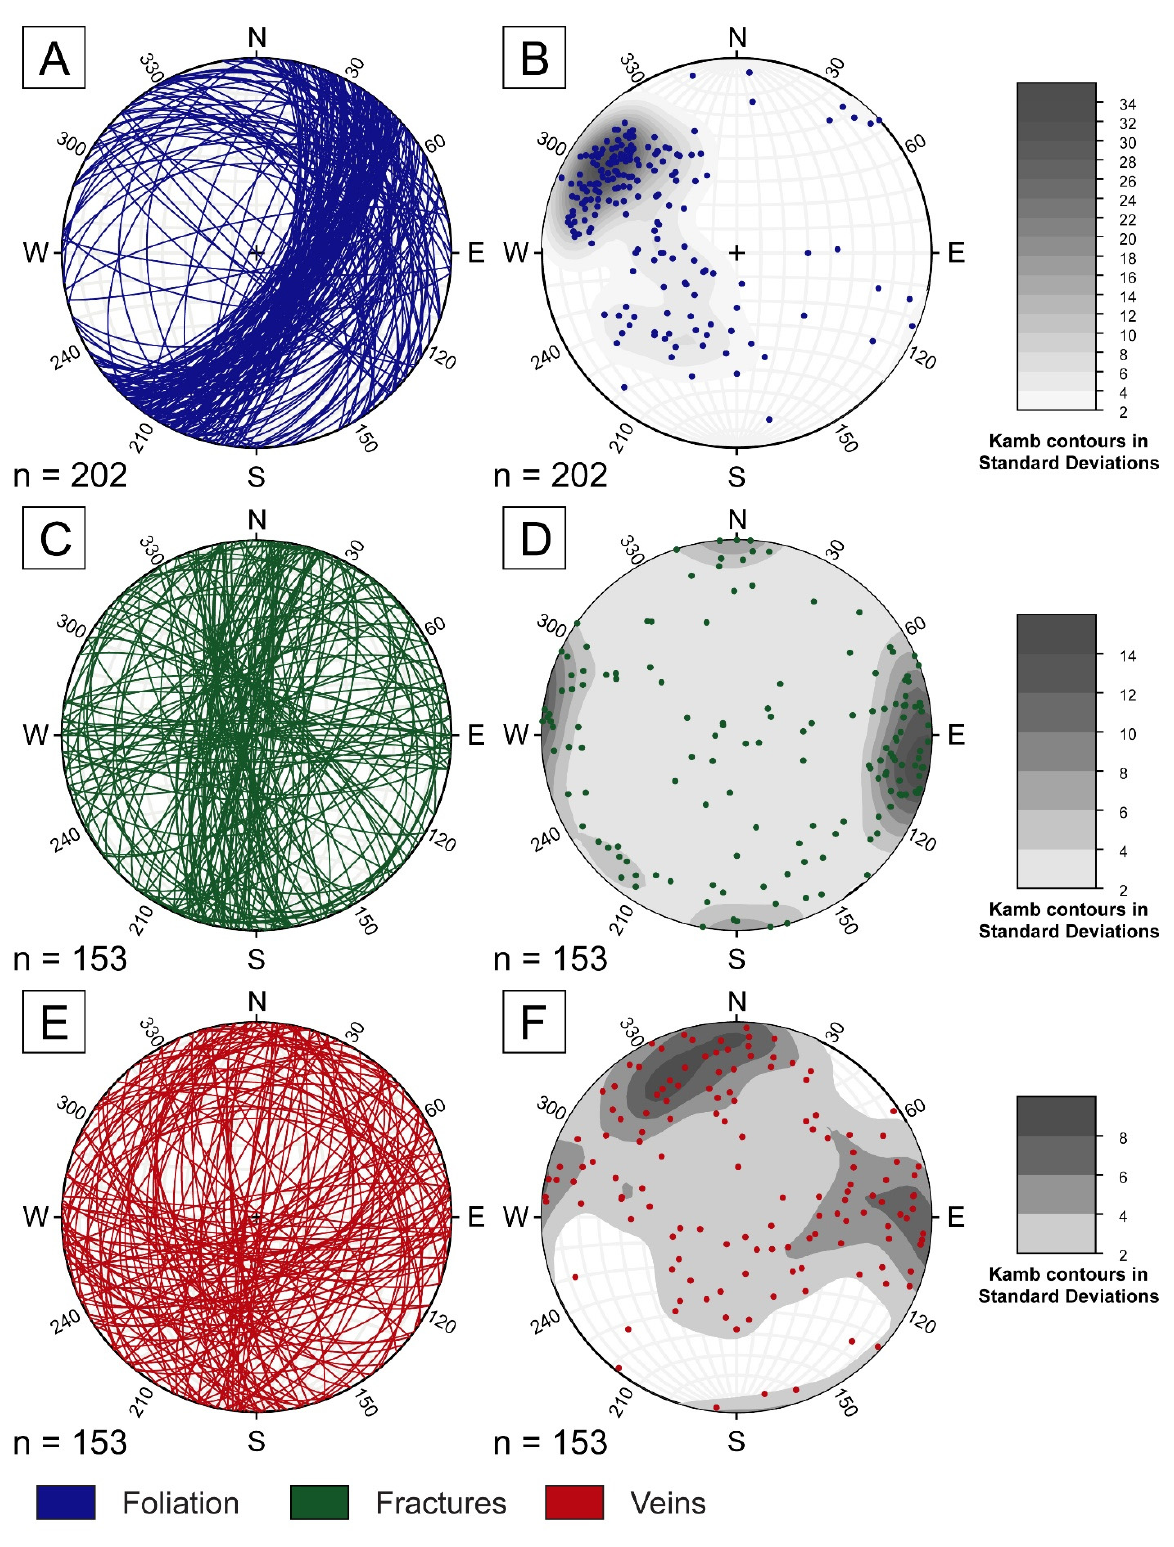
Figure 10. Planar and polar (pole-to-plane) plots with density contours of structures in the Miller Creek area (field and drillhole data). ( A , B ) foliation; ( C , D ) fractures; ( E , F ) veins.